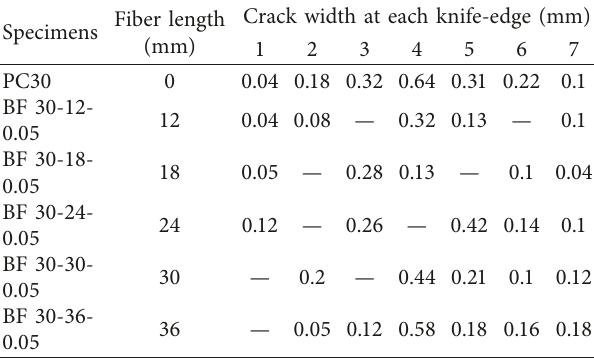
Table 5: Crack width of test specimens with different fiber lengths.